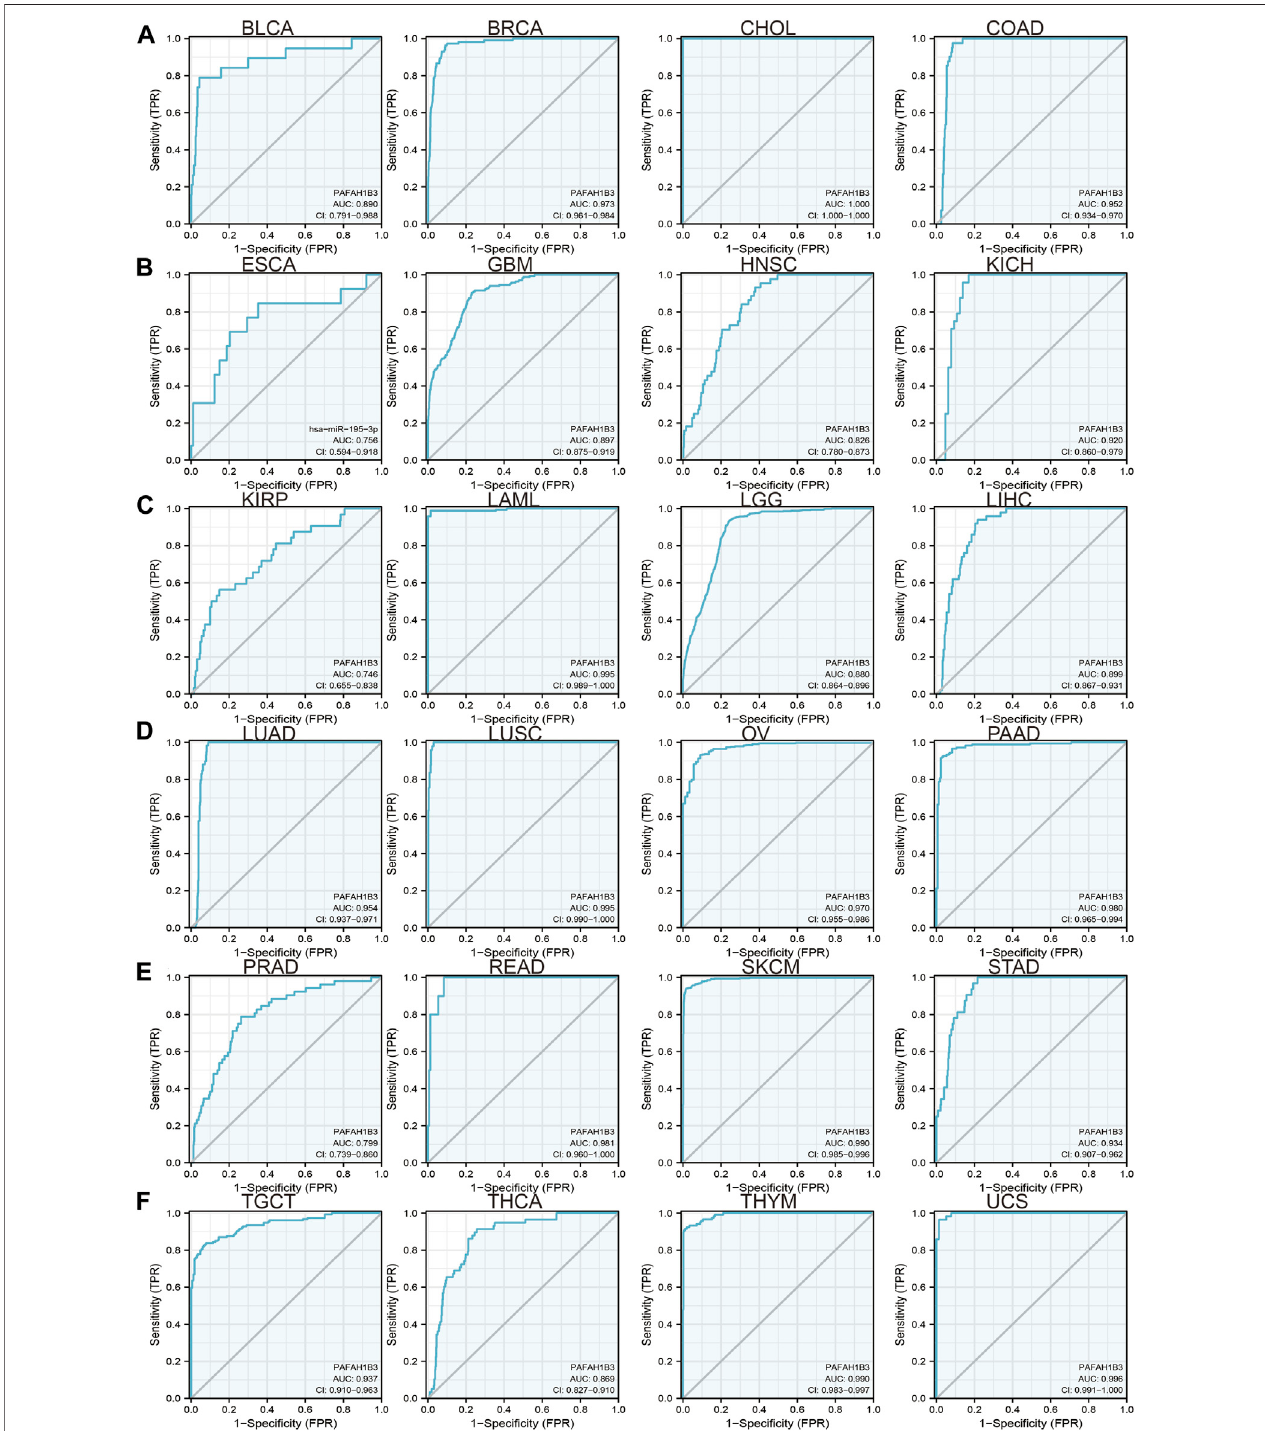
FIGURE 3 | ROC curve analyses and AUC values for PAFAH1B3 in diverse cancer. (A – D) ROC curve analysis and AUC values for PAFAH1B3 in BLCA, BRCA, CHOL,andCOAD. (B) ROCcurveanalysisand AUCvaluesforPAFAH1B3 inESCA,GBM,HNSC, andKICH. (C) ROCcurveanalysisand AUCvaluesforPAFAH1B3 in KIRP, LAML, LGG, and LIHC. (D) ROC curve analysis and AUC values for PAFAH1B3 in LUAD, LUSC, OV, and PAAD. (E) ROC curve analysis and AUC values for PAFAH1B3 in PRAD, READ, STAD, and SKCM. (F) ROC curve analysis and AUC values for PAFAH1B3 in TGCT, THCA, THYM, and THYM.